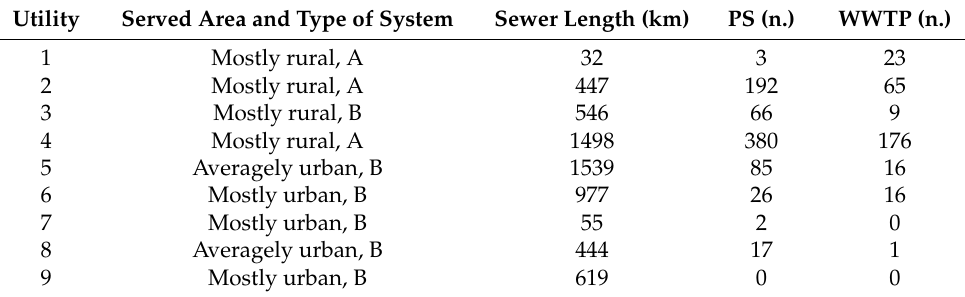
Table 2. Characteristics of systems used in evaluation at utility